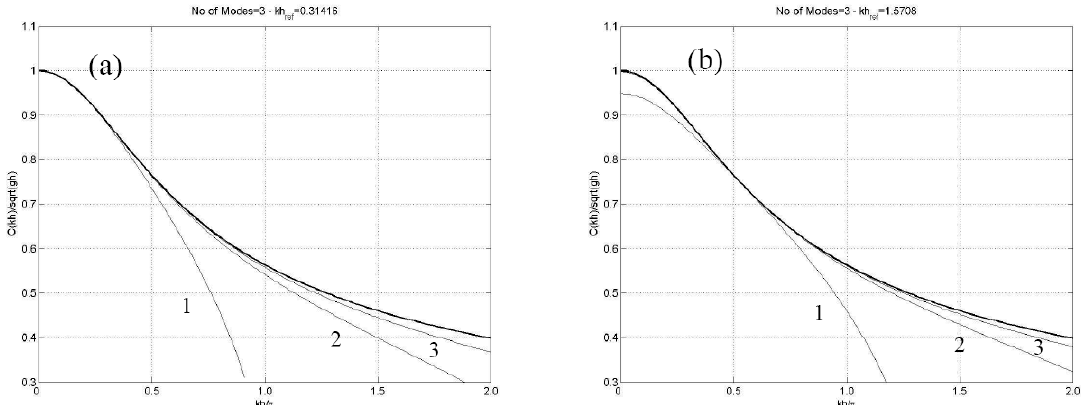
Figure 2. Dispersion characteristics of the linearized Coupled-Mode System (CMS) in the case of waves only in constant depth strip, using one term ( n = 0, indicated by 1), two terms ( n = 0,1, indicated by 2), and three terms n = 0,1,2, indicated by 3) in the local mode expansions; ( a ) µ 0 h = 0.1 π , ( b ) µ 0 h = 0.5 π